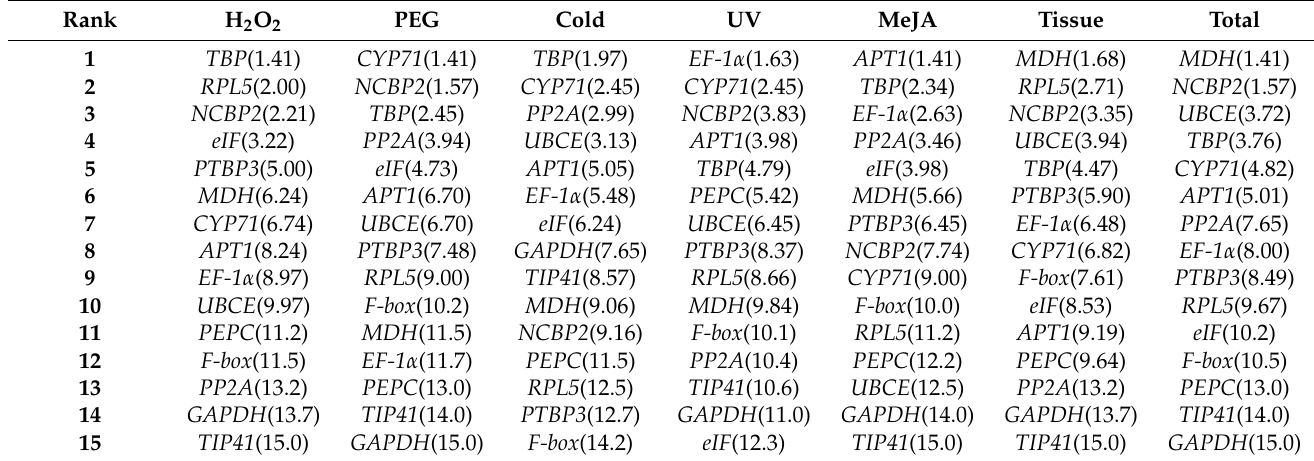
Table 4. Expression stability of candidate internal reference genes by RefFinder.